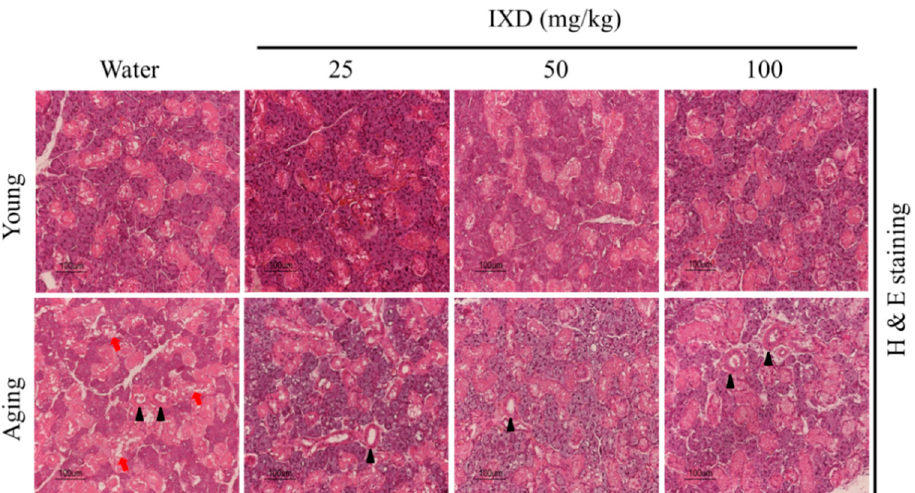
Figure 1. Ixeris dentate (IXD) improves aging-induced salivary dysfunction. Water or IXD extract was given orally to young and aging rats for eight weeks. Saliva and the submandibular glands were collected on the sacrificing day. ( A ) Weight of submandibular glands (g), * p < 0.05 vs. young control rats; ( B ) Total saliva collected over 30 min, * p < 0.05 vs. young IXD 100 mg/kg group; ( C ) Salivary flow rate by submandibular gland weight (mL/SMG weight/30 min); ( D ) Salivary flow rate by submandibular gland weight per minute (µL/SMG weight/min). * p < 0.05 vs. young control rats, # p < 0.05 vs. old control rats.